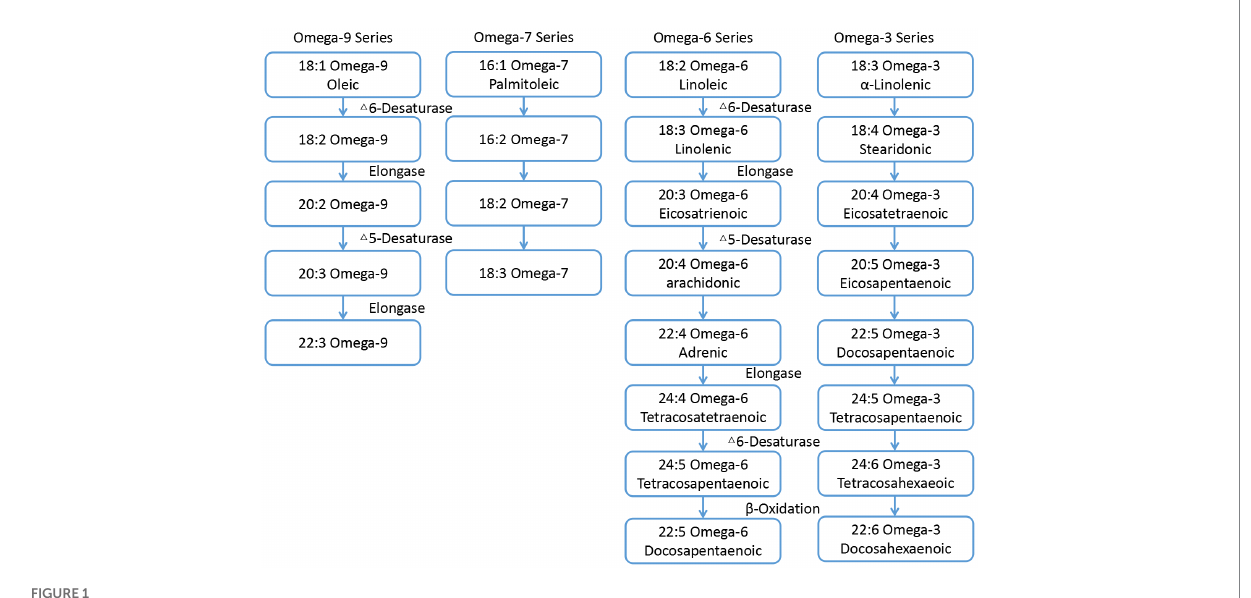
FIGURE 1 Schematic pathways of various fatty acids